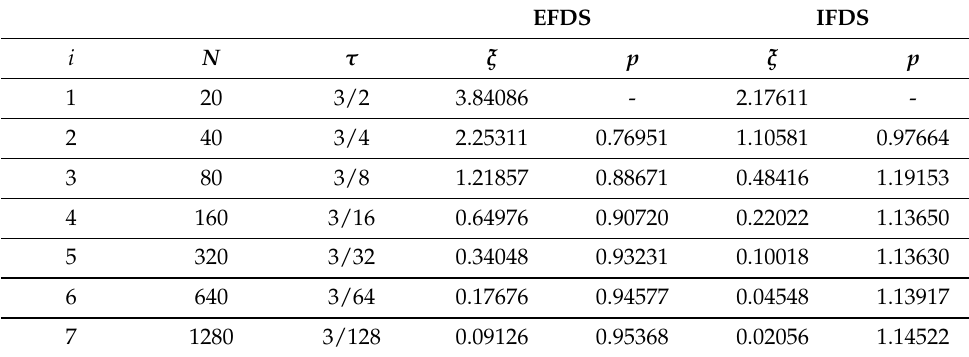
Table 1. Computational accuracy of EFDS and IFDS, at T =